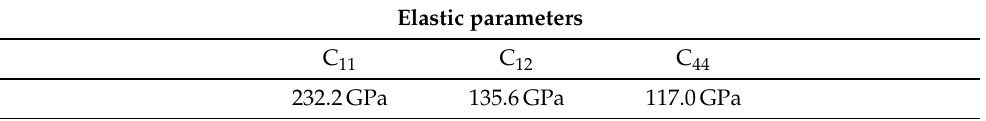
Table 3. CPFEM phenopower law model parameters for the sample material Fe3.2wt.%Si with a homogeneous and a banded